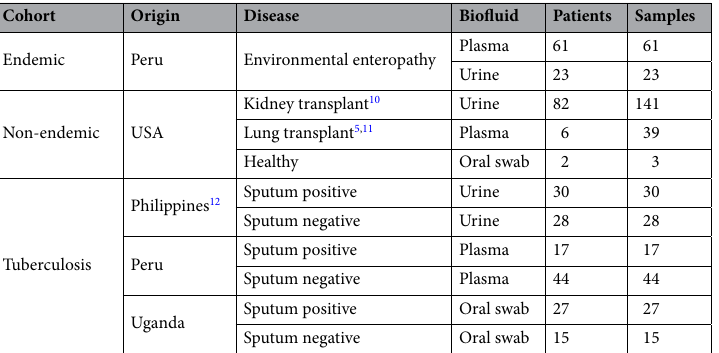
Table 1. Overview of datasets included in this study. All data was generated for this study unless otherwise